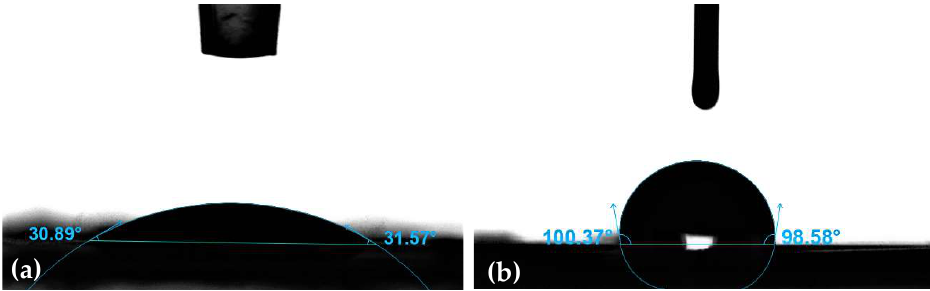
Figure 2. Contact angles of CC in ( a ) water and ( b ) caprylic / capric acid triglyceride (CT).